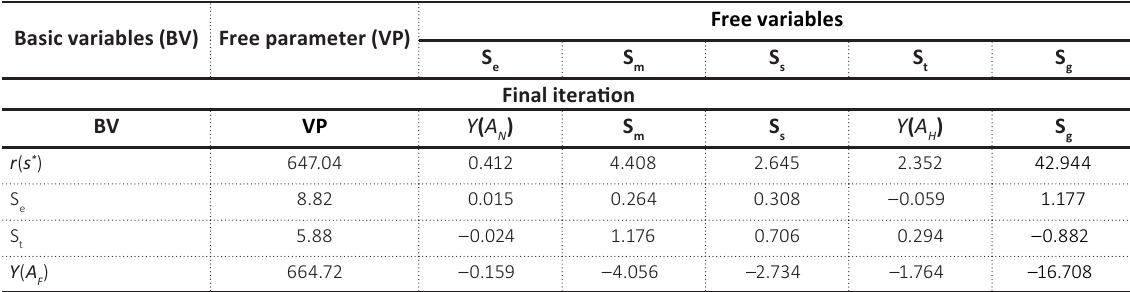
Table A2 (cont.). Iterations of linear programming (destination of nature-based tourism specializing in services of “wow-effect”